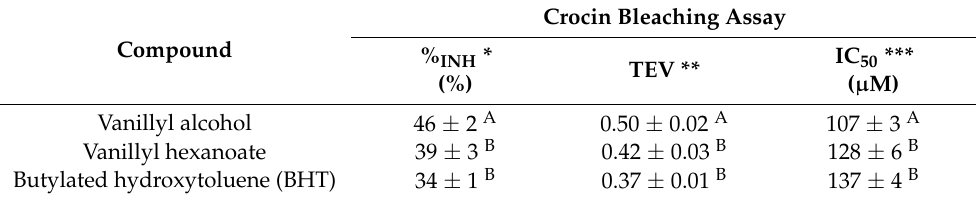
Table 2. Comparison of antioxidant activity of vanillin alcohol, vanillyl hexanoate, and BHT by crocin bleaching assay.